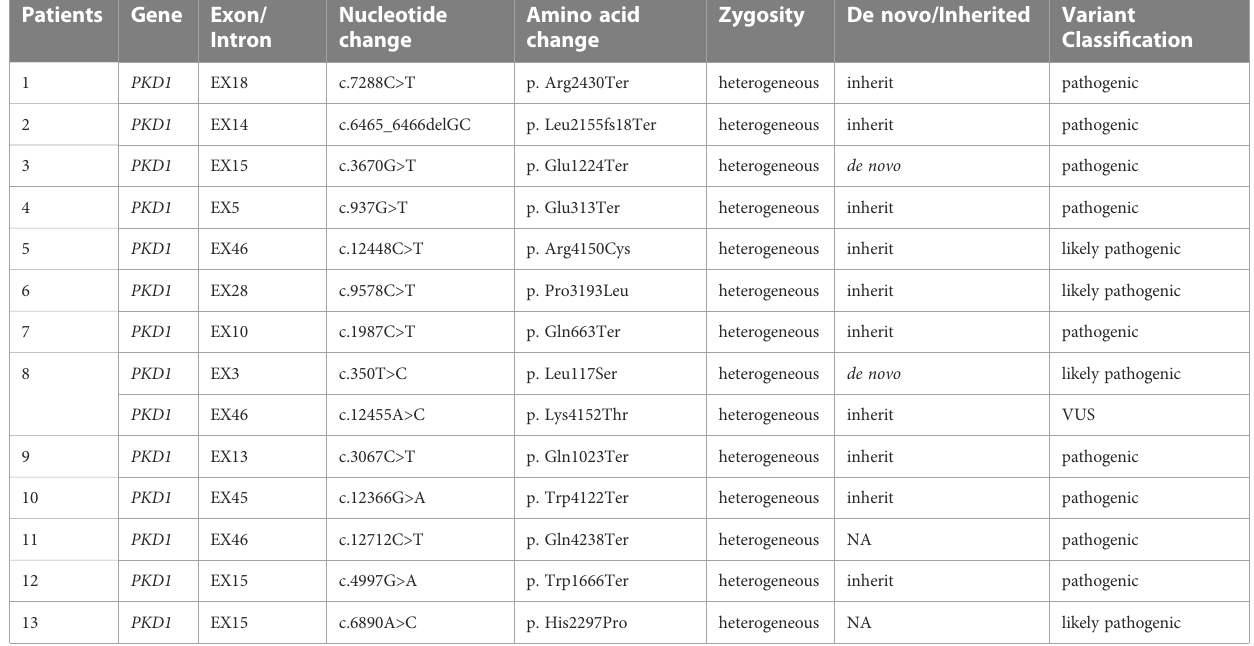
TABLE 1 Genetic information of the ADPKD